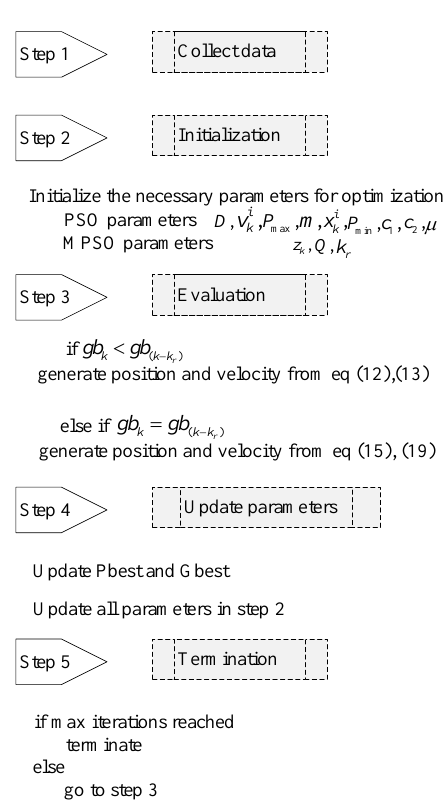
Figure 4. Flowchart of modified particle swarm optimization